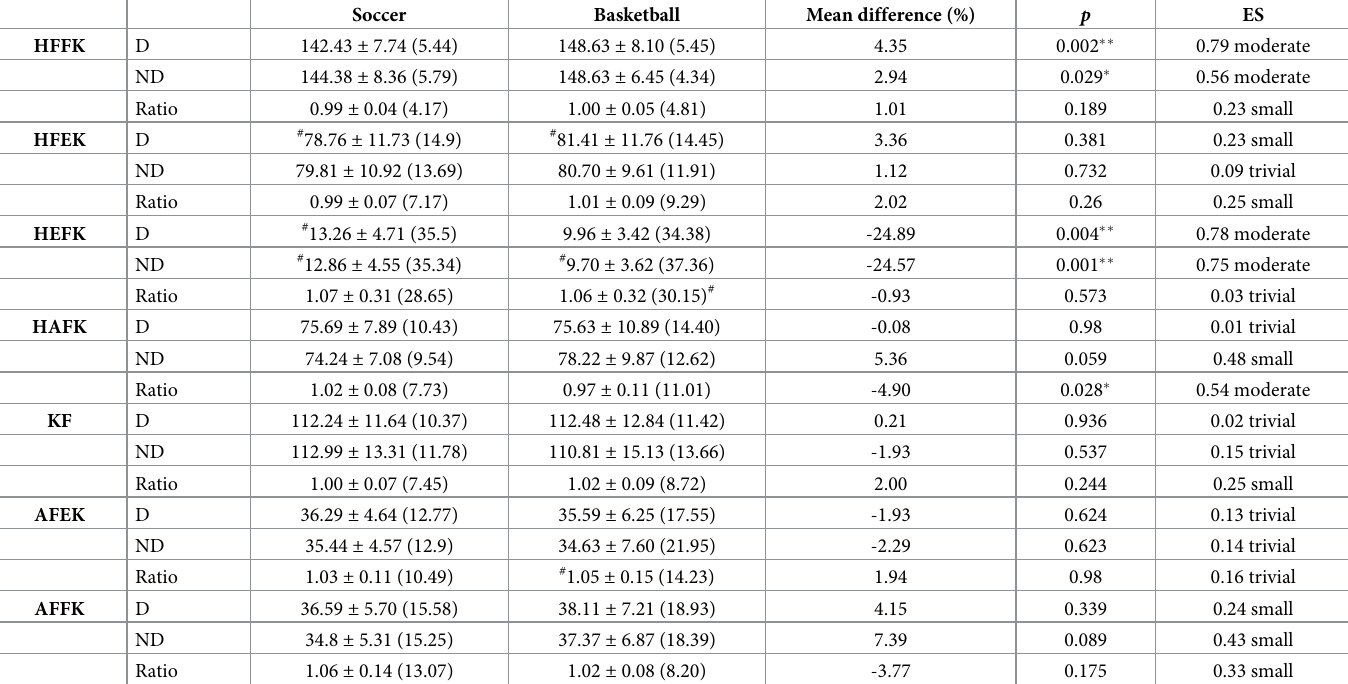
Table 2. ROM values comparisons between soccer and basketball players. Soccer Basketball Mean difference